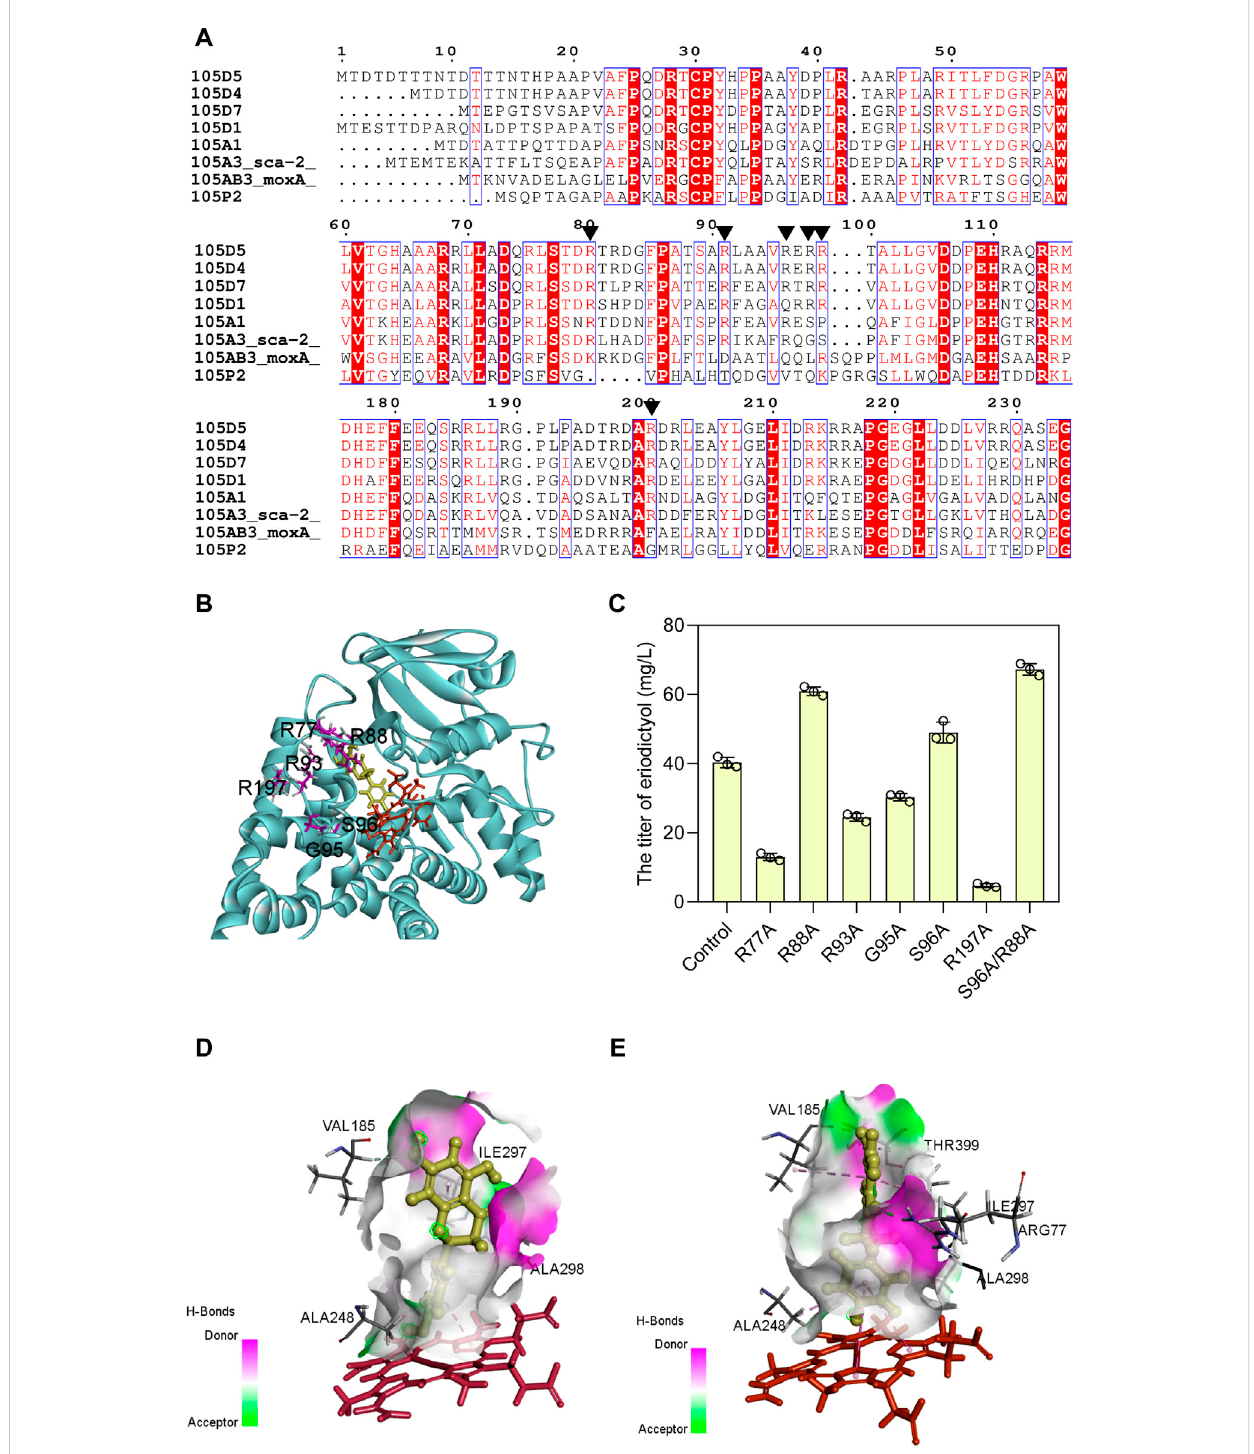
Enhancing the catalytic activity of sca-2 mut by sequence-guided engineering. (A) Amino acid sequence alignment using the representative CYP105 family. Black triangle indicates the conserved arginine residues on the surface of an active site. (B) Selection of amino acids used as mutations (R77,R88,R93,G95,S96,andR197)arepositionedaroundthesubstrateareaofsca-2. (C) Titersoferiodictyolproducedbyengineeringstrainscontaining sca-2 mutants. (D) The interactions between naringenin and sca-2 mut model. (E) The interactions between naringenin and sca-2 mut R88A/S96A model. Heme was indicated as red and ligand indicated as yellow. The data are shown as mean ± SD of three biological